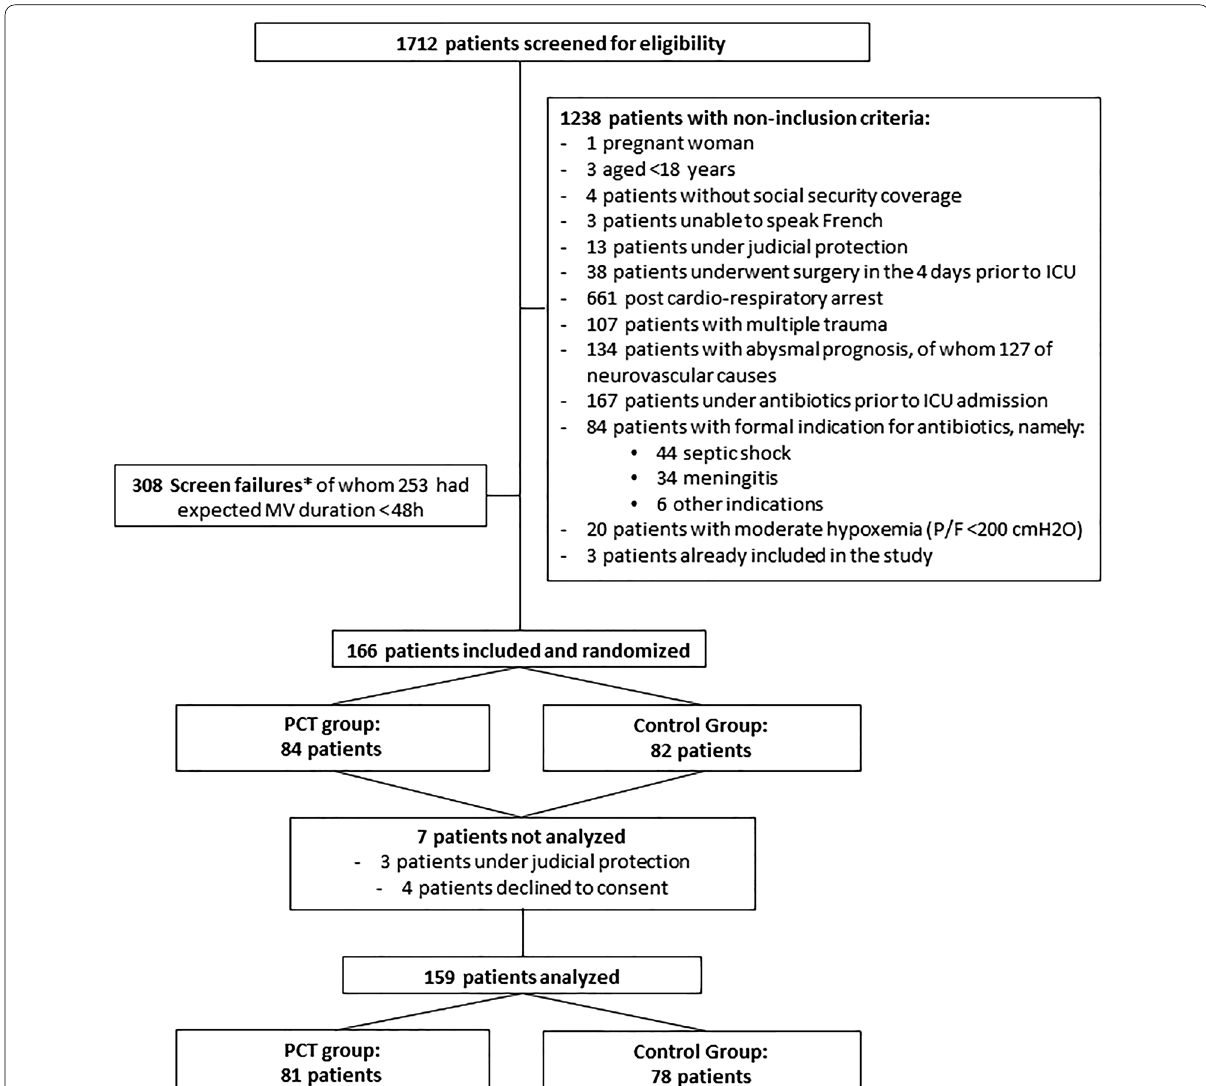
Fig. 3 Flowchart of the study population. *Screen failures